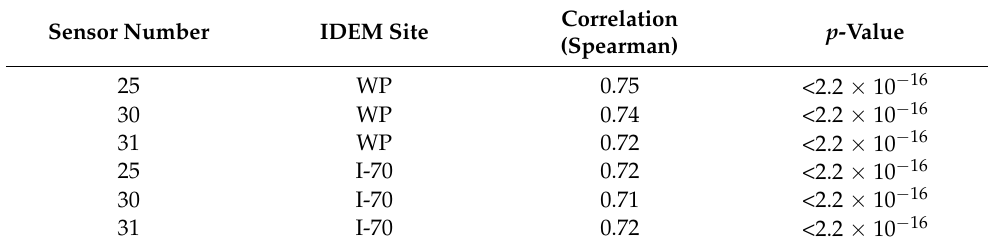
Table 1. Correlation of sensors 25, 30, and 31 with IDEM monitors and PM 2.5 data.